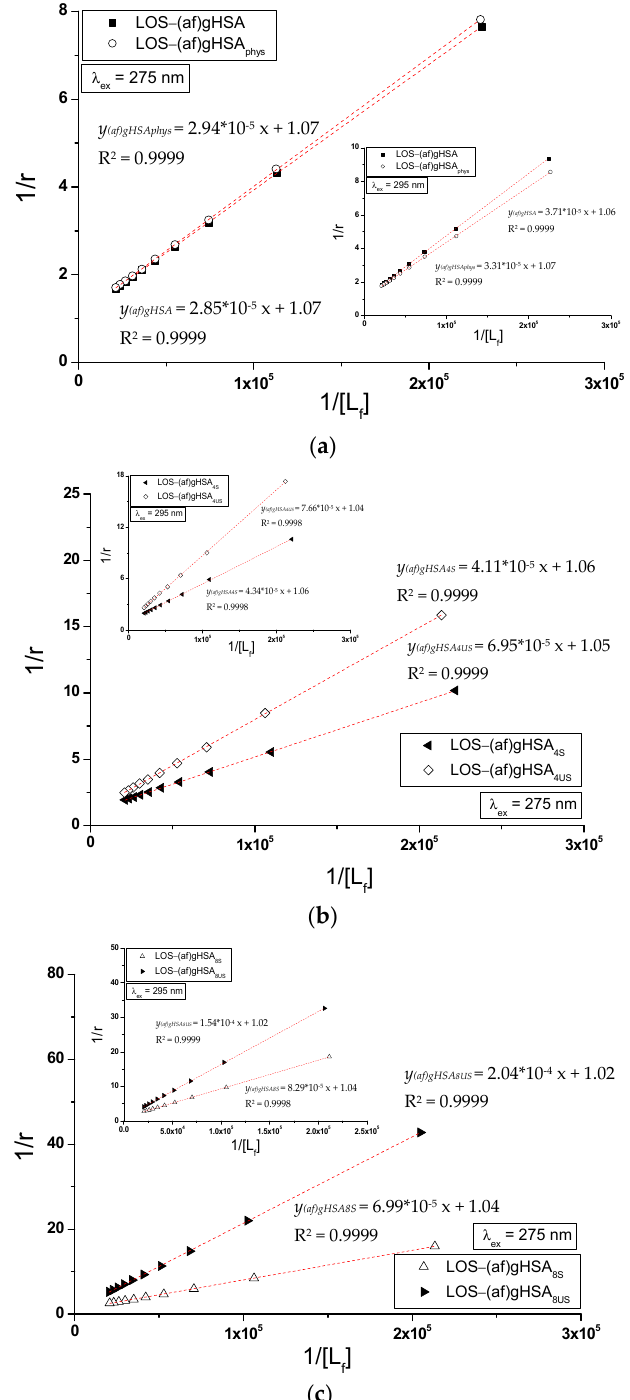
Figure 8. The Klotz curves of 1/r vs. 1/[L f ] for ( a ) LOS-(af)gHSA and LOS-(af)gHSA phys , ( b ) LOS-(af)gHSA 4S and LOS-(af)gHSA 4US , and ( c ) LOS-(af)gHSA 8S and LOS-(af)gHSA 8US systems, λ ex = 275 nm (in the main view), λ ex = 295 nm (in the insert); the error bars are smaller than the symbols. In the Scatchard equation, the concentration of the bound ligand to the protein is the independent variable, while, in the Klotz equation, the independent variable is the reciprocal of the free ligand fraction. To study the possible cooperation of losartan binding to the macromolecule, the Hill interaction factors (n H ) were determined by the use of the Hill equation (the dependence of log[r/(1 − r)] on log[L f ], Equation (6), Figure